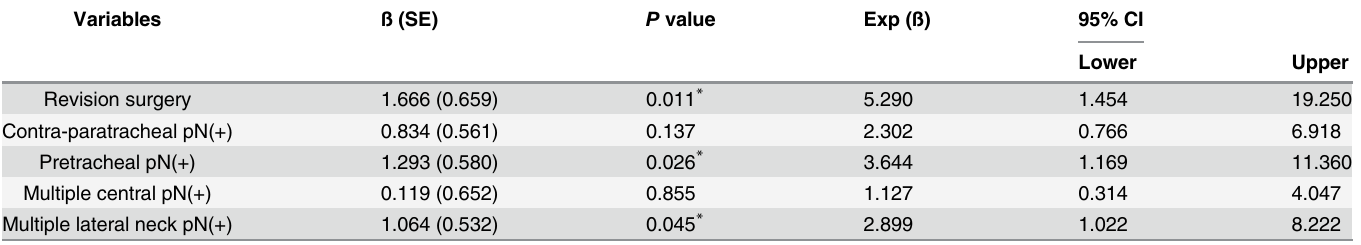
Table 4. Multivariate logistic regression for SMLN metastasis. Contra: contralateral, SMLN: superior mediastinal lymph node, SE: standard error, Exp (ß): exponential (ß), CI: confidence interval,